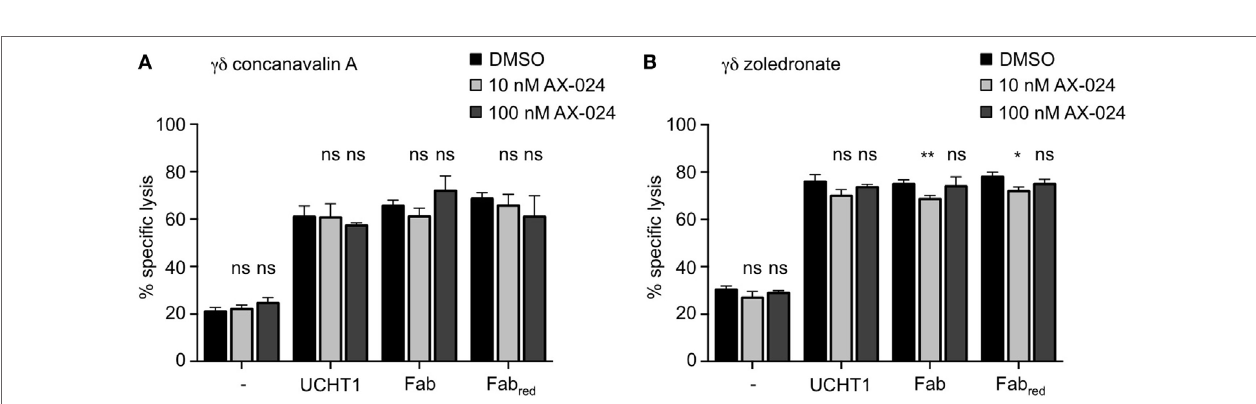
FigUre 6 | Tumor killing by γδ T cells is independent of Nck recruitment to the γδ T cell antigen receptor. 51 Cr-labeled Daudi cells were incubated with concanavalin A (a) or zoledronate (B) expanded γδ T cells without ( − ) or with 5 µg/ml UCHT1, 3.33 µg/ml Fab, or 3.33 µg/ml Fab red . In addition, 10 or 100 nM of AX-024 was included or not. The effector to target ratio was 12.5:1. After 5 h of co-culture, the amount of released 51 Cr was measured in the supernatant by γ -ray spectroscopy. Data represent mean ± SD of triplicates ( n = 3). Significance was determined by unpaired t -test, two-tailed between untreated samples and samples treated with